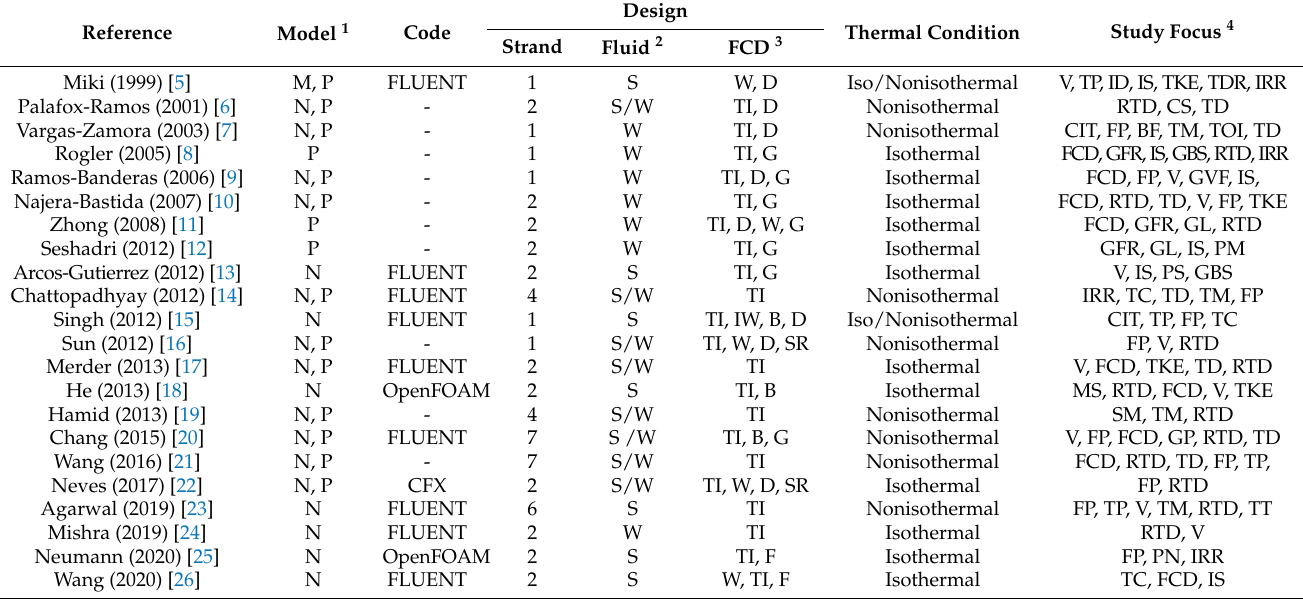
Table 1. Summary of modeling studies on flow control devices in tundish.